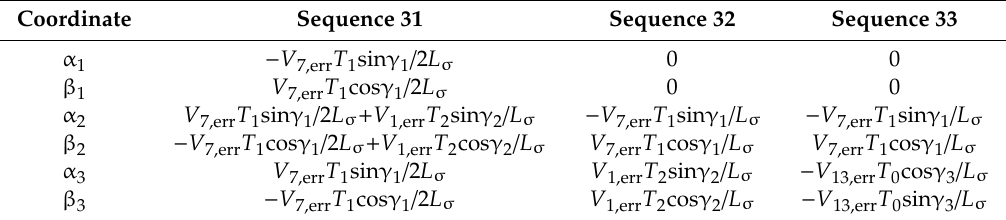
Table A1. The coordinate of three vertexes of current ripple